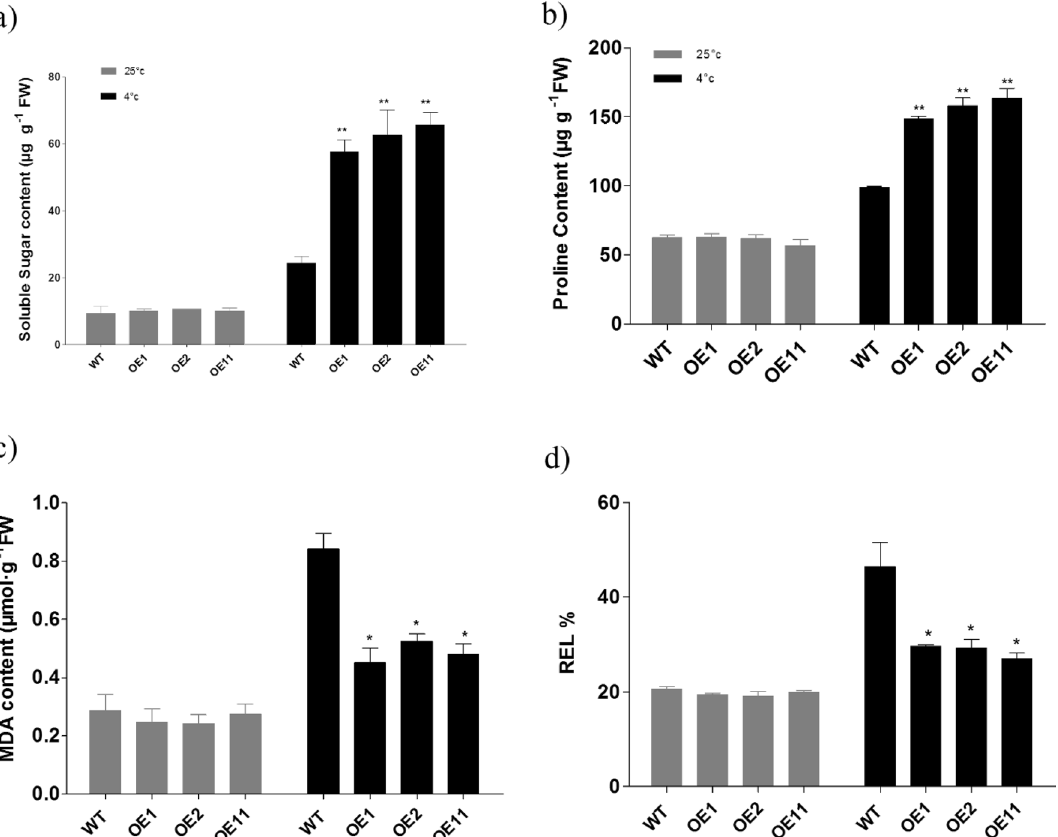
Figure 5. Low temperature induced accumulation of osmoprotactants and Evaluation of membrane damage in WT and transgenic lines ( a ) represents soluble sugar accumulation by transgenic and wild-type tomato ( b ) proline accumulation by WT and BoCRP1 expressing tomato plants at ambient temperatures and after being treated cold stress (4 °C) for 3 days. ( c ) MDA content ( d ) REL. The data represents the mean ± SD of three Biological replicates Asterisks represents the statistically significant differences between WT and BoCRP1 expressing lines. * P < 0.05;** P < 0.01; *** P < 0.001 Tukey’s Multiple Comparison